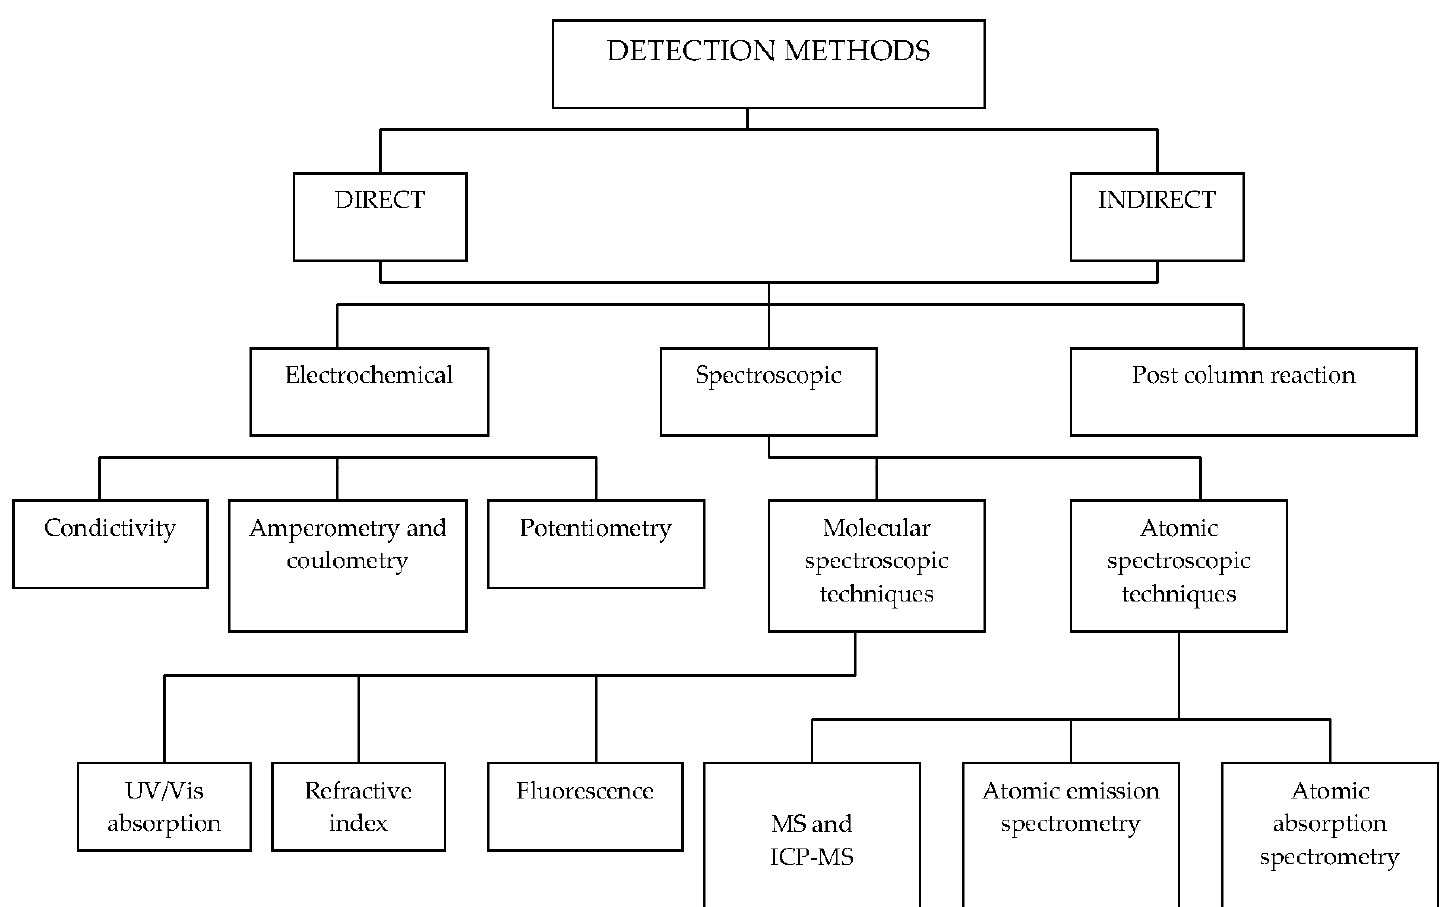
Figure 2. Division of detection methods for ion chromatography.